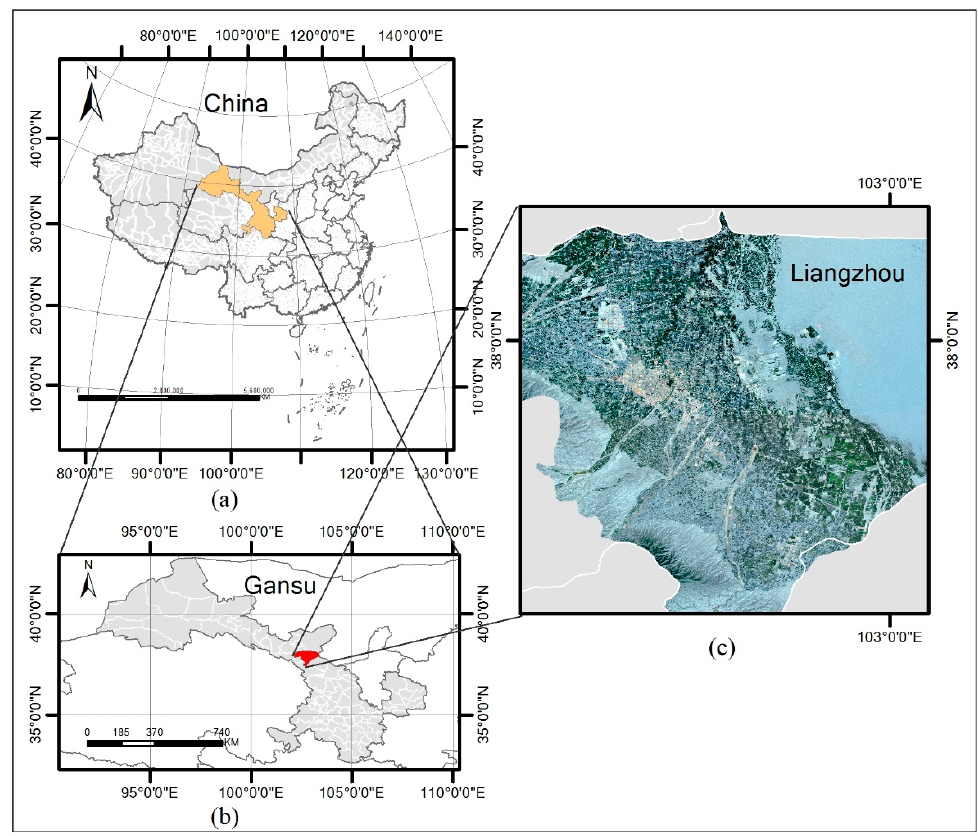
Figure 1. Study regions. ( a ) Gansu province, China; ( b ) Location of the study region in Gansu province; ( c ) true-color Sentinel-2 image of Liangzhou.